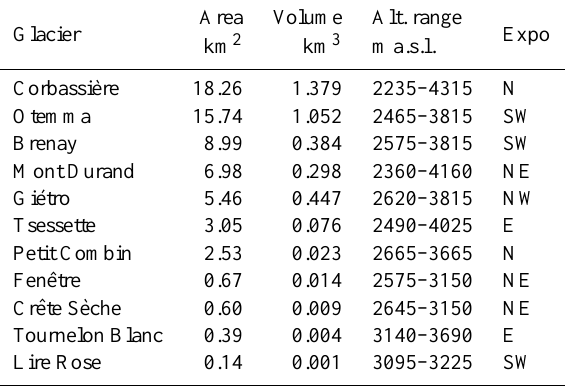
Table 1. Area, ice volume, altitudinal range and main exposition of the glaciers in the Mauvoisin region. Data refer to 2009.